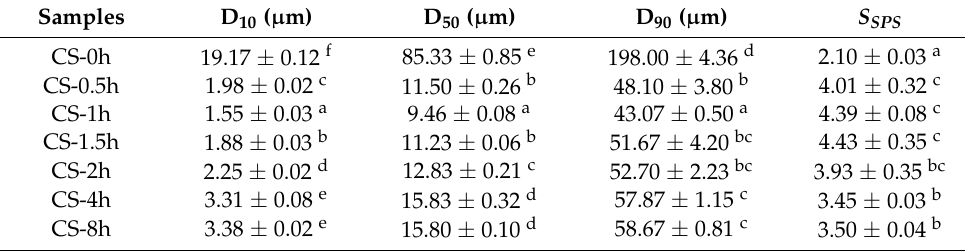
Table 2. Average particle diameters and span of corn straw samples with different ball grinding